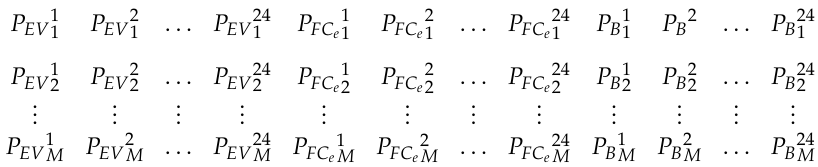
Figure 3. Chromosomes in one generation of the real coded genetic algorithm